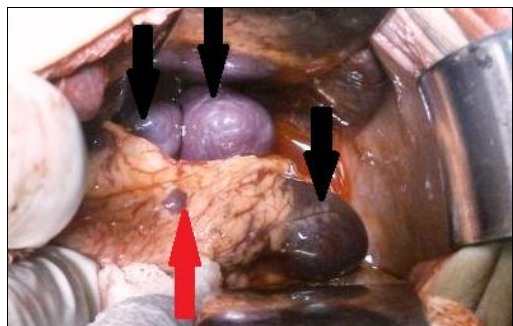
Figure 2: Intra-operative picture of polysplenia, Black arrows – multiple spleens, Red arrow – splenenculus in